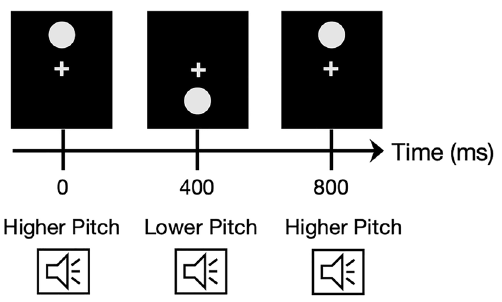
Figure 3. Schematic illustration of the stimulus observation phase of Experiment 2.